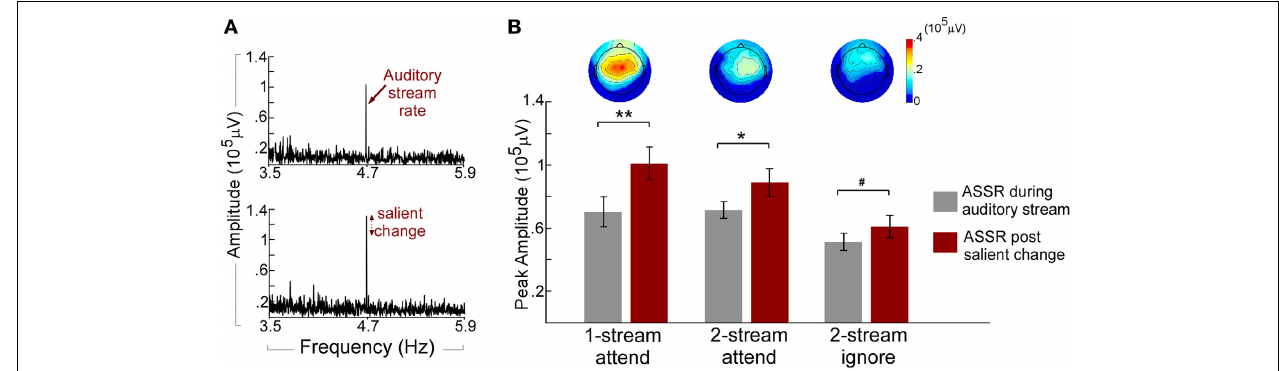
FIGURE 3 | (A) Example ASSR peak during the auditory stream and post salient change. The spectrum of the neural response for one participant in the one-stream attend experiment is obtained by concatenating 320 trials at the Cz electrode. The Top panel shows the spectrum obtained during the auditory stream segment of the trial (prior to any change) and shows a clear peak at 4.7Hz entrained to the tempo of the music notes. The Bottom panel depicts further enhancement in the 4.7-Hz peak after a salient change is introduced in